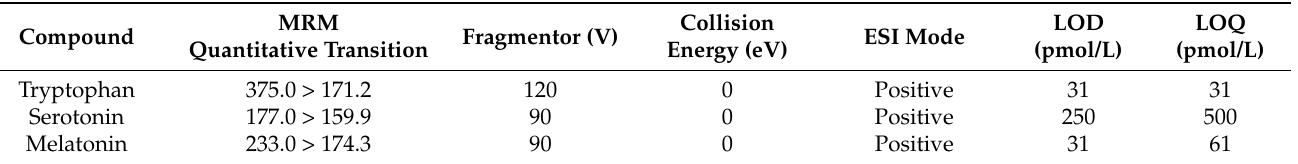
Table 1. UHPLC-ESI-QqQ-MS/MS parameters for identifying and quantifying tryptophan, serotonin, and melatonin in grape stems, pomace, and wine